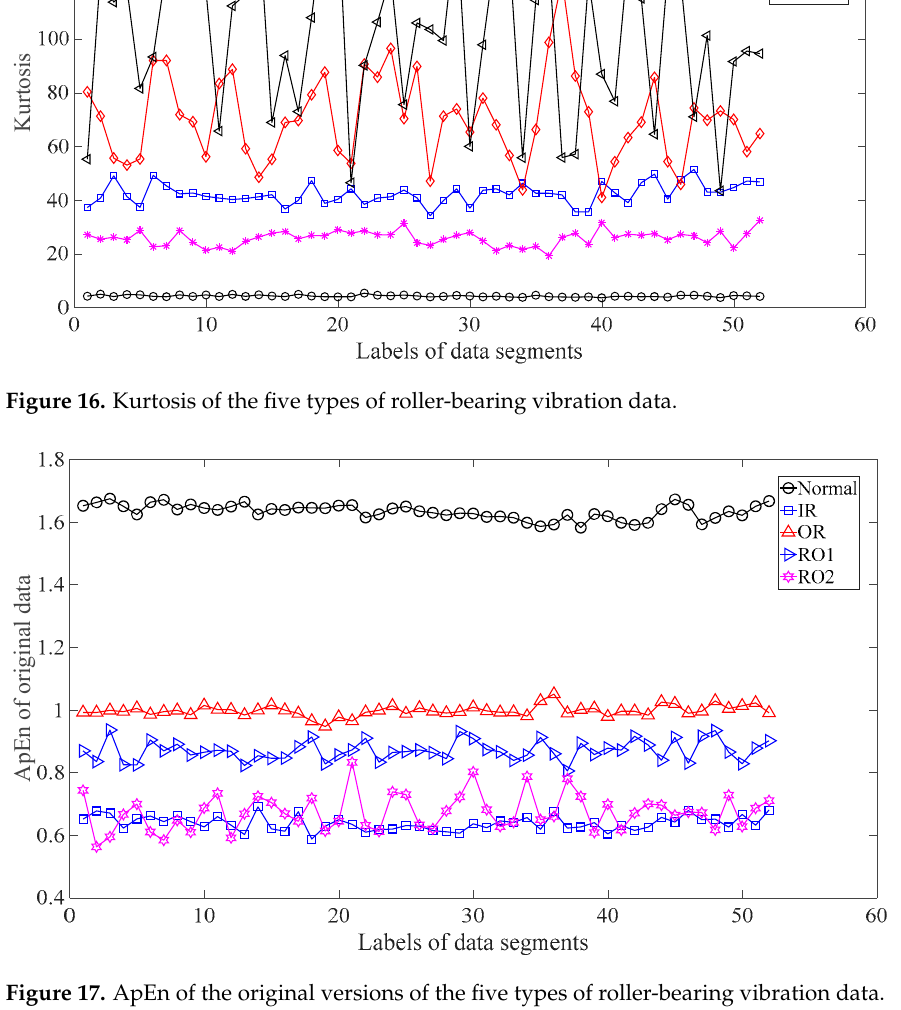
Figure 18. ApEn of the shuffle versions of the five types of roller-bearing vibration data.